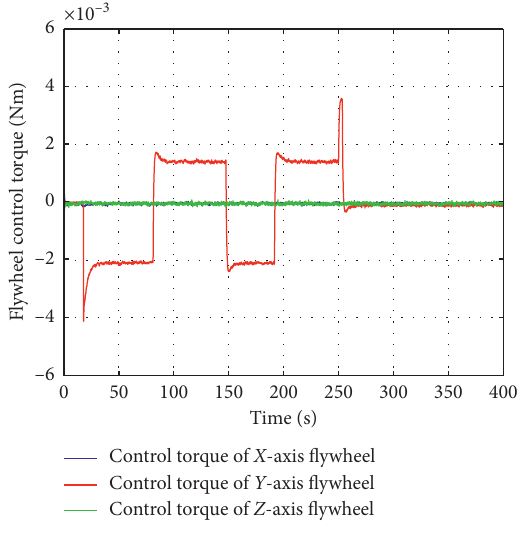
Figure 8: Flywheel control torque.